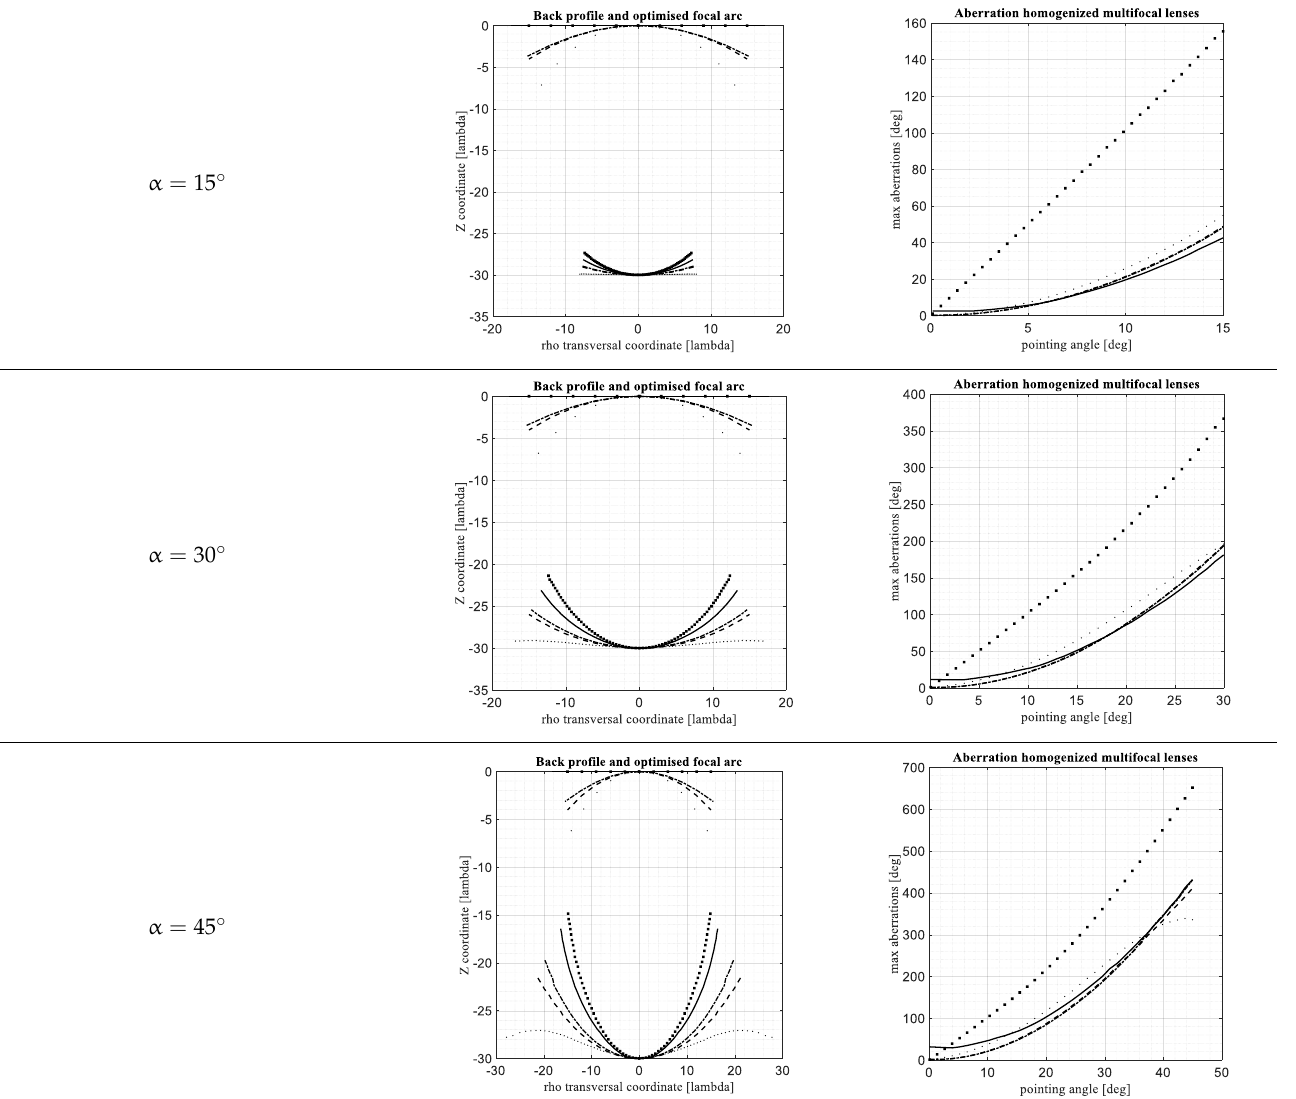
Table 1. M = zooming = 1.